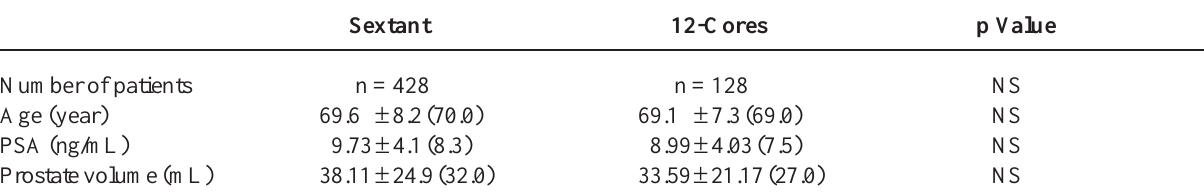
Table 1 – Patient